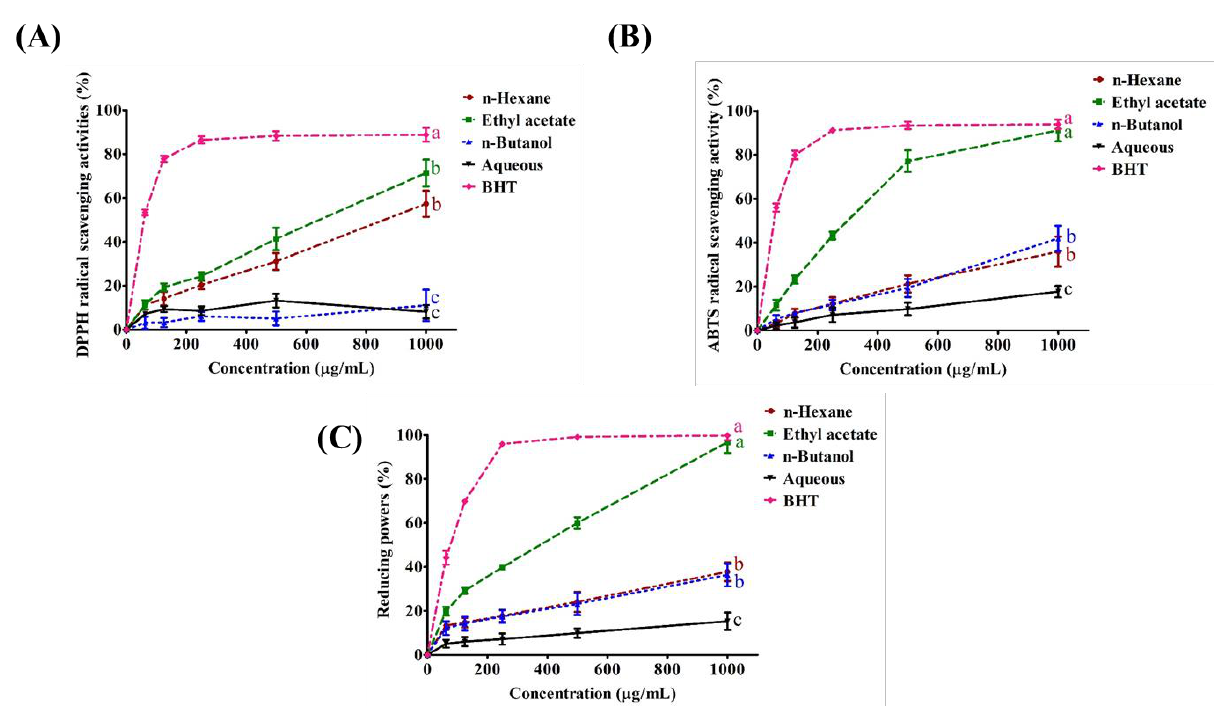
Figure 1. The antioxidant activities of 75% methanol crude extract and its different solvent partitions including n-hexane, ethyl acetate, n-butanol and water from freeze-dried powder of Phellinus linteus mycelia. Each value represents the mean ± standard deviation (SD, n = 3) SD of triplicate experiments. ( A ) DPPH radical scavenging activity, ( B ) ABTS radical scavenging activity and ( C ) reducing power on ferric ions. Means with different letters are significantly different ( p < 0.05).